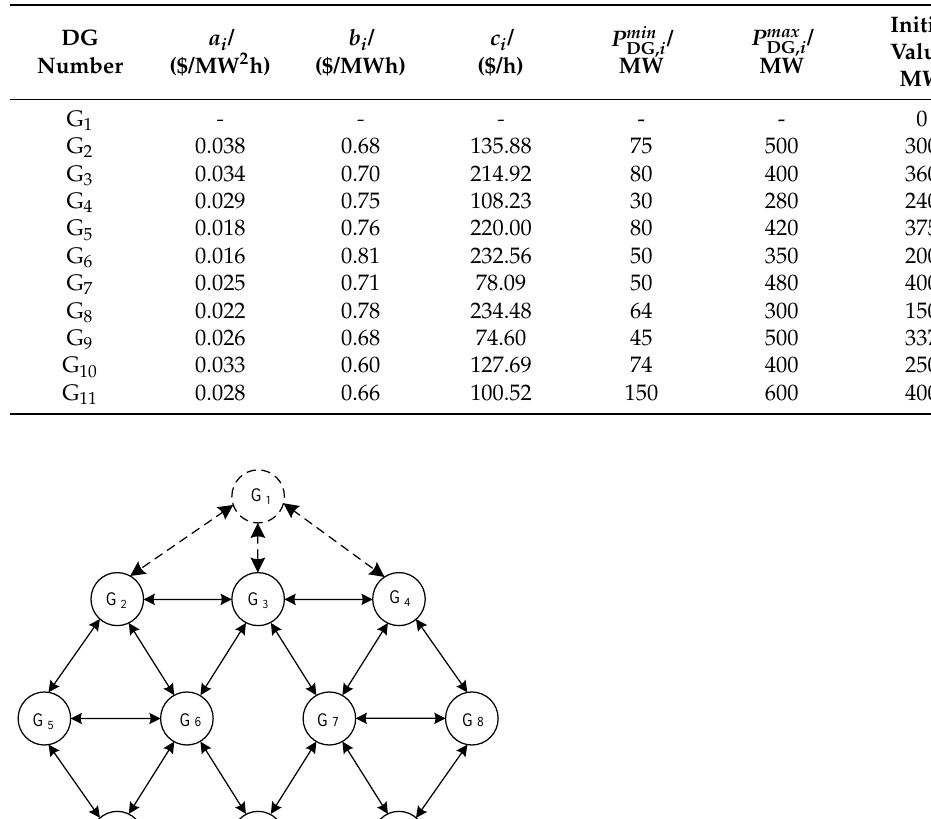
Table 2. Parameters of the DGs in the IEEE-39 system.